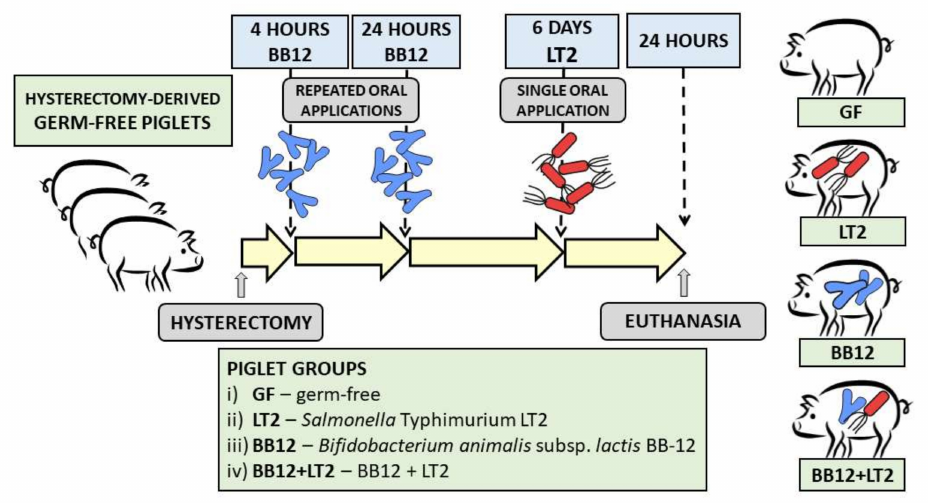
Figure 1. Experiment design. Gnotobiotic piglets ( n = 24) were assigned into four groups with six piglets per group: (i) germ-free (GF); (ii) infected with Salmonella Typhimurium strain LT2 (LT2); (iii) associated with probiotic Bifidobacterium animalis subsp. lactis BB-12 (BB12); (iv) associated with BB12 and infected with LT2 (BB12 +